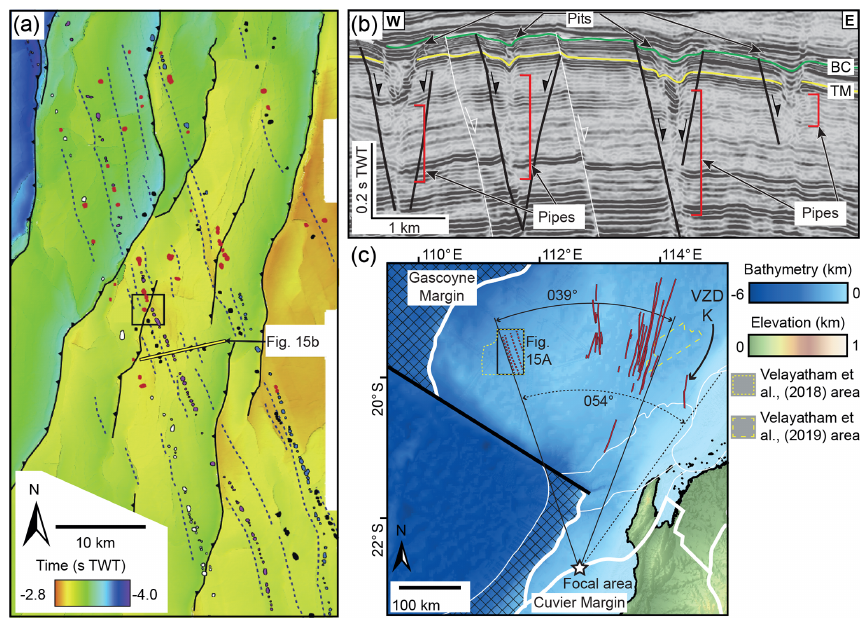
Figure 15. (a) Near Base Cretaceous unconformity time–structure map from the western sector of the Exmouth Plateau, with interpreted dyke-induced normal fault traces (dashed lines) and pit craters (circles) highlighted (modified from Velayatham et al., 2018). See (c) for location. (b) Interpreted seismic section showing the cross-section structure of possible dyke-induced normal faults and pit craters (modified from Velayatham et al., 2018). See Fig. 15a for location. (c) Map of dykes interpreted in this study and those perhaps marked by possible dyke-induced faults and pit craters in the western sector of the Exmouth Plateau (see also Velayatham et al., 2018). The interpreted dykes broadly define a radiating swarm, across at least a 39 ◦ arc, centred on a focal area on the Carnarvon Terrace on the Cuvier Margin. We note the orientation of VZD K fits poorly with the radiating geometry of the rest of the dyke swarm, but if it is part of the Exmouth Dyke Swarm we suggest that the swarm could extend across a ∼ 54 ◦